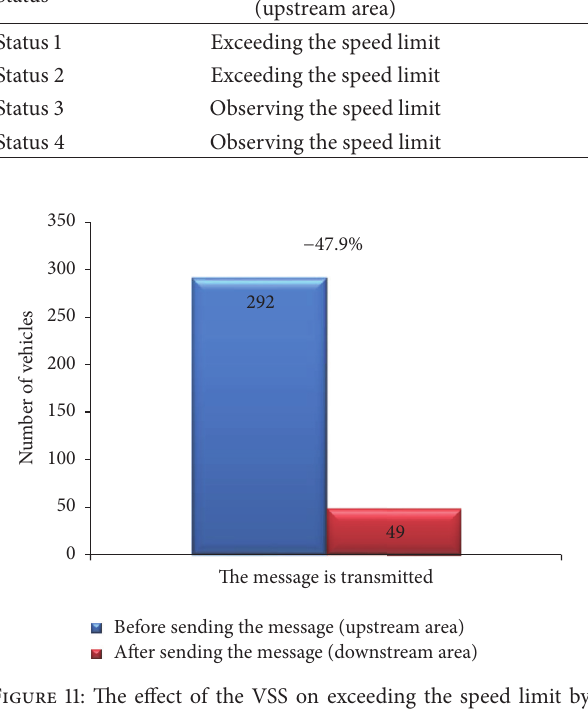
Figure 11: The effect of the VSS on exceeding the speed limit by 10km/h or more.